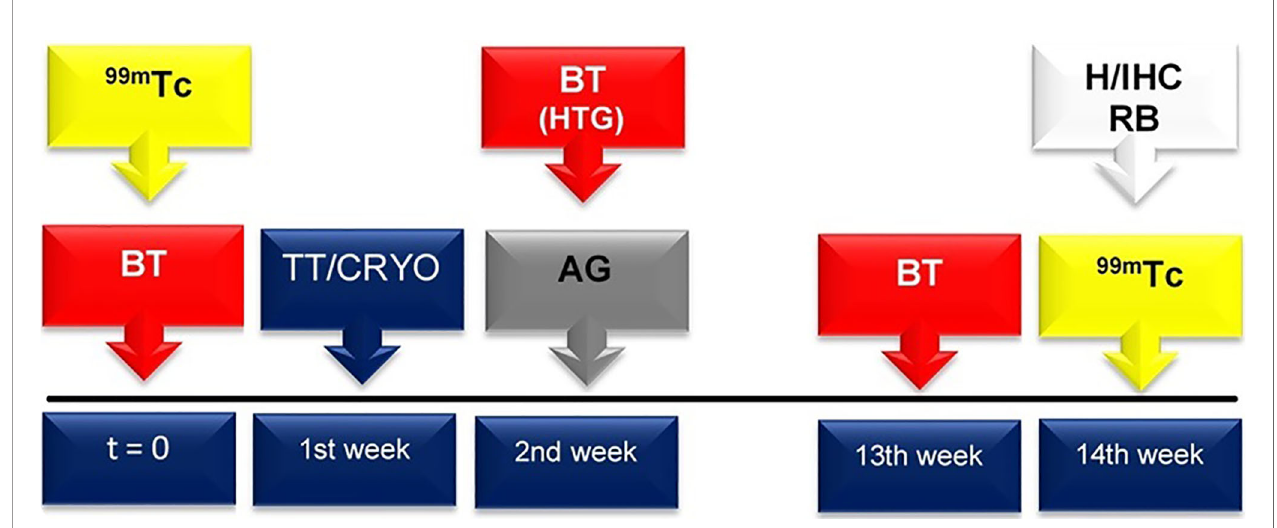
FIGURE 1 | At both t = 0 and 13 weeks, biochemical tests (BT), including serum levels of total T3, free T4 and TSH, and total calcium, were performed for all groups (red box with arrow). In the HTG, the thyroid hormone and calcium serum levels were also determined one week after thyroidectomy (that is, in the 2nd week after the beginning of the experiment). Total thyroidectomy (TT) and cryopreservation (CRYO) of the thyroid gland occurred in the 1st week (blue box with arrow). In the 2nd week, the autologous graft (AG) was implanted in the TG (grey box with arrow). In both the t = 0 and 14th weeks, scintigraphic examination (99mTc) was accomplished (yellow box with arrow). In the 14th week, histological evaluation (H), immunohistochemistry analysis (IHC) and radioisotope biodistribution (RB) were performed (white box with